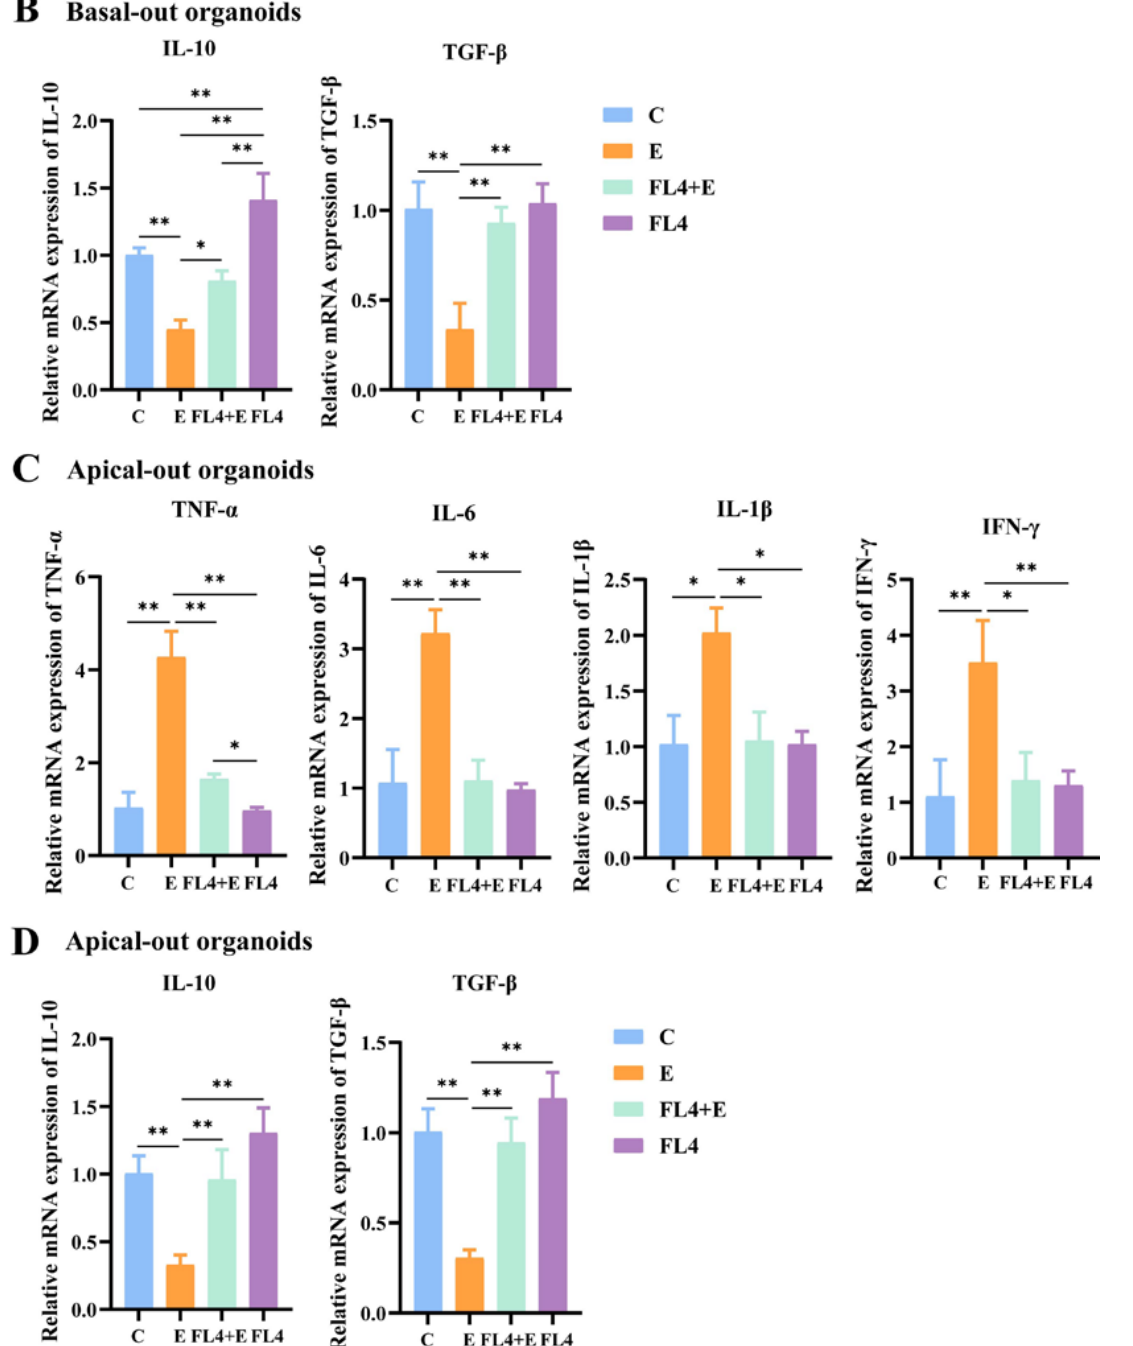
Figure 10. L. fermentum (FL4) modulated ETEC K88-induced inflammatory responses. ( A ) Expression of pro-inflammatory cytokines TNF- α , IL-6, IL-1 β and IFN- γ treated with/without ETEC K88 or FL4 in basal-out organoids. ( B ) Expression of anti-inflammatory cytokines IL-10 and TGF- β treated with/without ETEC K88 or FL4 in basal-out organoids. ( C ) Expression of pro-inflammatory cytokines TNF- α , IL-6, IL-1 β and IFN- γ treated with/without ETEC K88 or FL4 in apical-out organoids. ( D ) Expression of anti-inflammatory cytokines IL-10 and TGF- β treated with/without ETEC K88 or FL4 in apical-out organoids. n = 3. * p < 0.05, ** p <